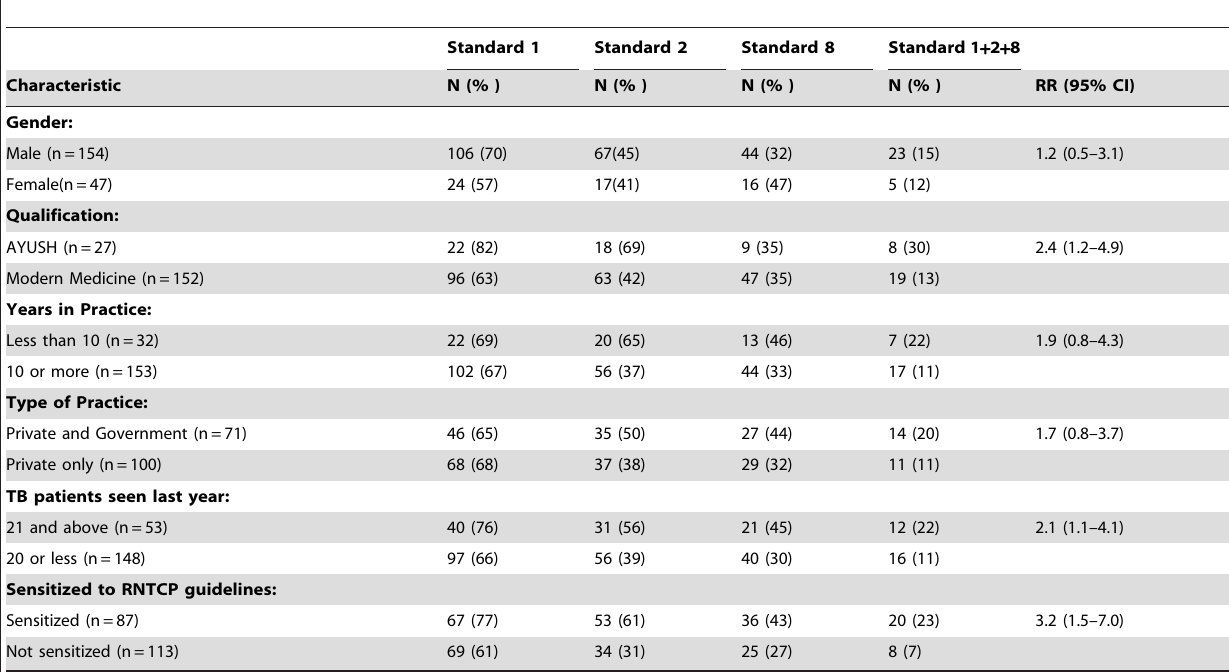
Table 4. Characteristics of private practitioners in relation to compliance with 3 selected core ISTC * in Visakhapatnam, AP.